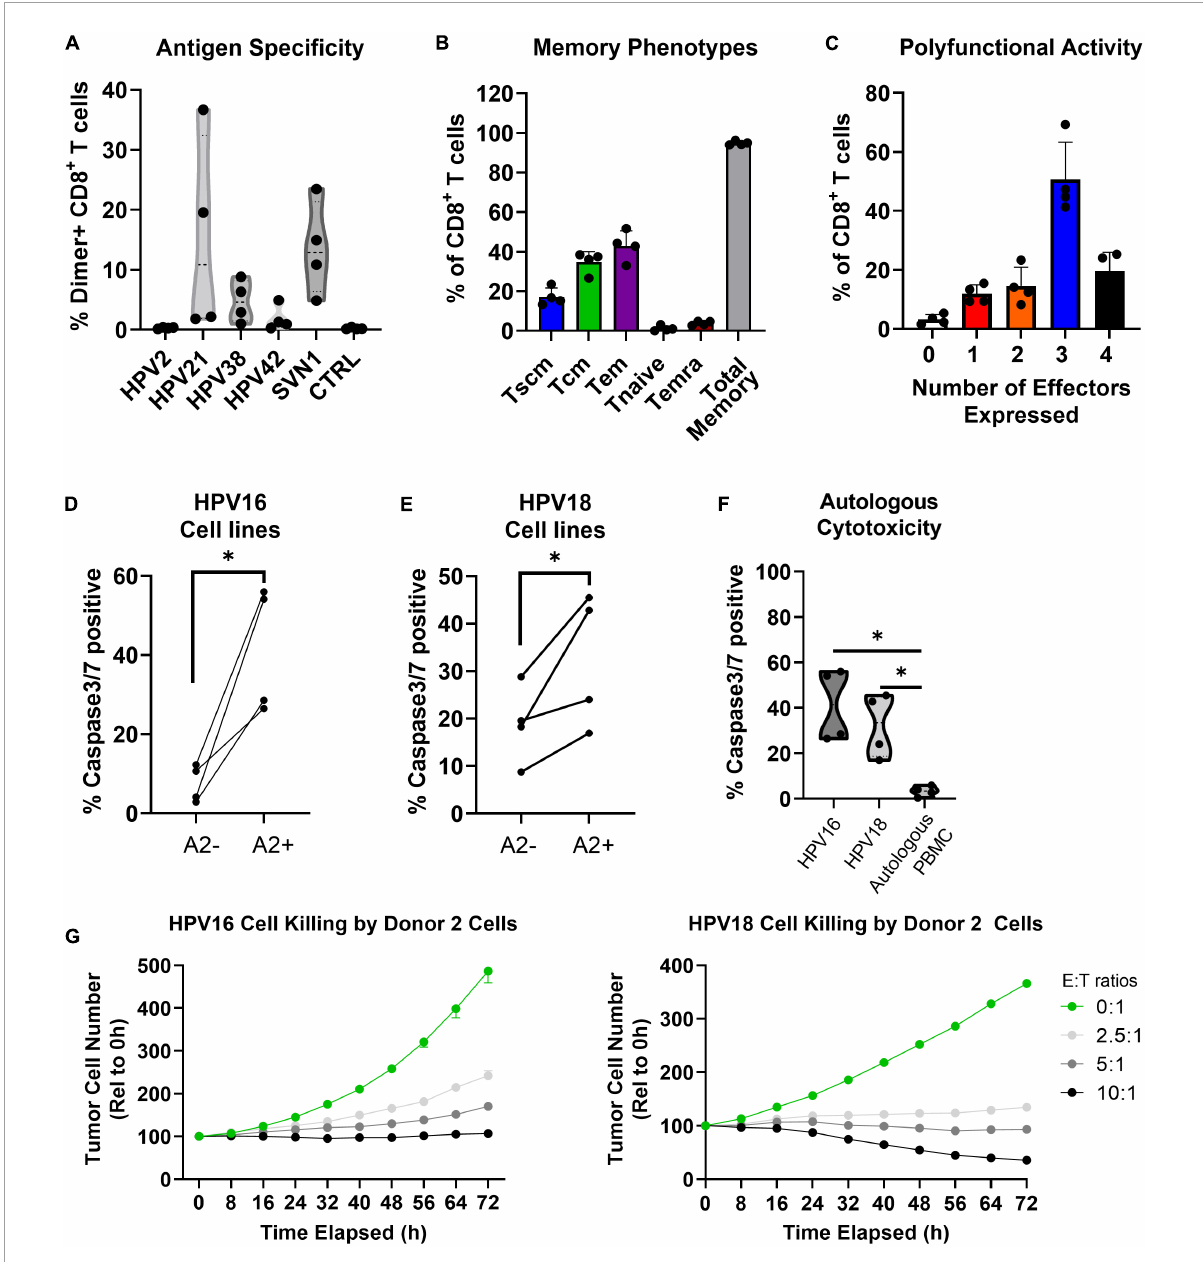
FIGURE6 In the preclinical validation of NEXI003, the AIM platform consistently generated high quality cytotoxic T cells for HPV-associated cancer treatment. Results are reported from four independent runs for the validation of NEXI-003 ( n = 4). (A) The percentage of peptide specific (Dimer+) cells among CD8 + T cells (Mean ± StdDev). (B) The memory phenotype of CD8 + T cells. (C) The percentage of CD8 + T cells that express 0-4 total functional markers ( i.e ., CD107a, IL-2, IFN γ , and TNF α ) upon stimulation with PMA/Ionomycin (Mean ± StdDev). (D–F) The percentage of live target cells that were caspase-3/7 positive after coculture with E+E cells at a 10:1 E:T ratio. Target cells that were HLA-A2 positive ( i.e. , CaSki or HeLa-A2) are directly compared to those that were HLA-A2 negative ( i.e ., SiHa or HeLa) or were autologous PBMCs. Statistical difference tested by ratio paired T test ( ∗ p ≤ 0.05). (G) HPV-16 + or HPV-18 + HLA-A2 expressing cell lines ( i.e. , CaSki or HeLa-A2, respectively) were cultured for 72 h alone or with E+E cells from Donor 2 at E:T ratios of 2.5:1-10:1. Reported is the tumor cell number relative to the 0 h (Mean ± SEM; n = 3). Effector cell to target cell ratio (E:T